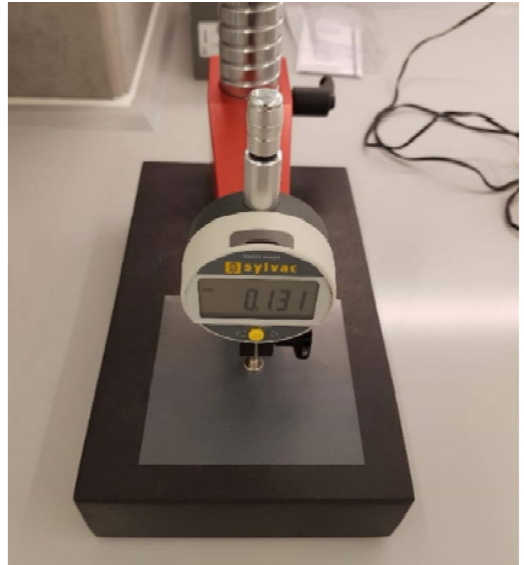
Figure 5. Mechanical thickness measurements of a sample using a dial gauge from Sylvac. The samples were weighed on a scale to the nearest 0.01 g. Results were given in g/m 2